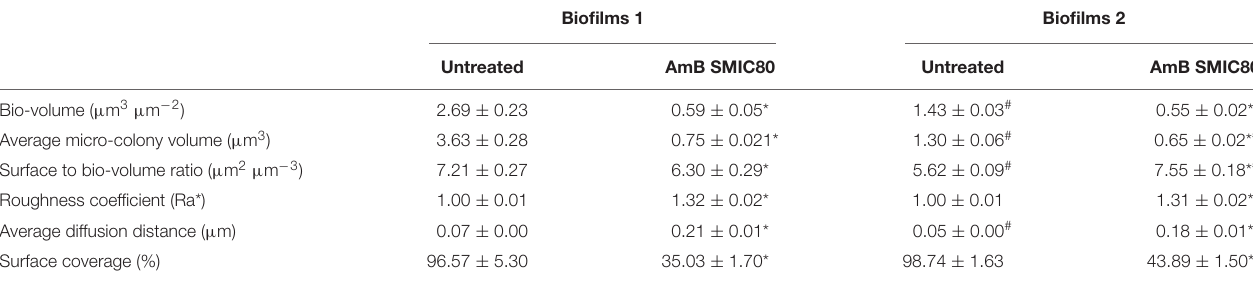
TABLE 1 | COMSTAT analysis of architectural parameters of Candida tropicalis NCPF 3111